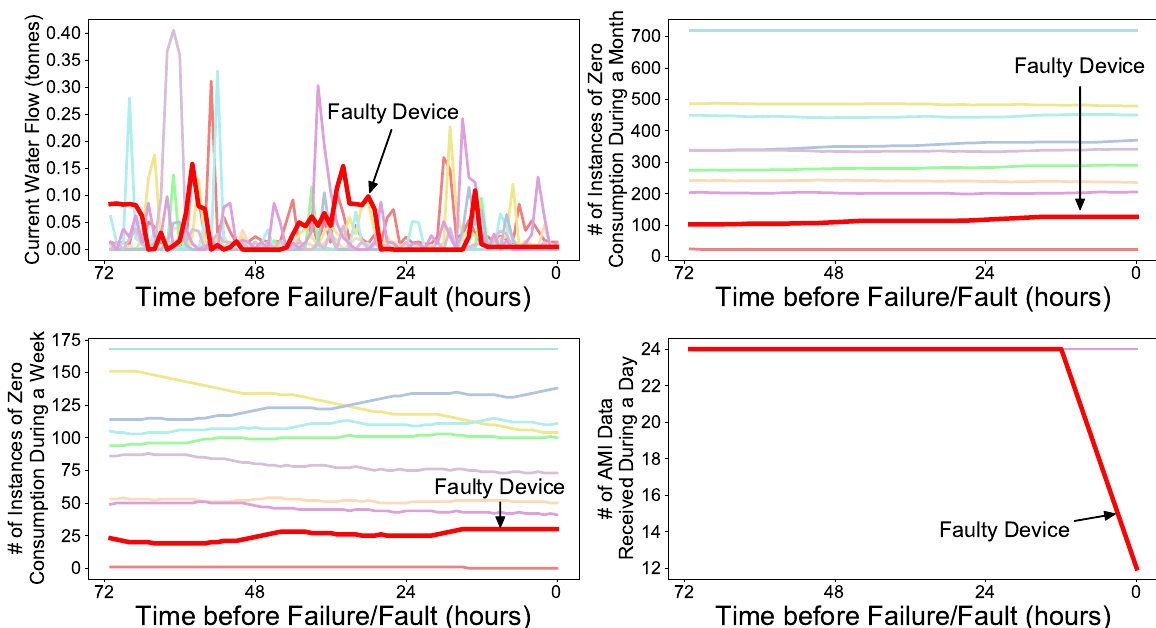
Figure 5. Extracted features of faulty (bold red) and healthy (other colors) devices until actual failure/fault of the RWMR device